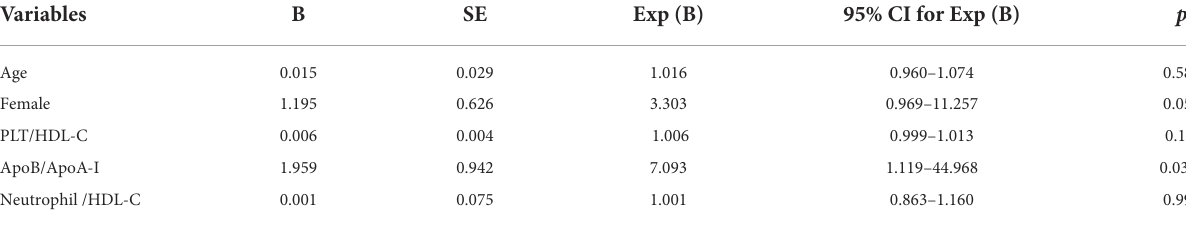
TABLE 2 Logistic regression analysis of factors related to mRS score of > 3 in patients with anti-NMDAR encephalitis